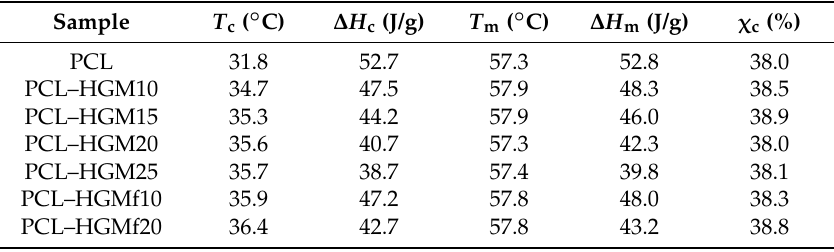
Table 3. DSC data for PCL and PCL-based